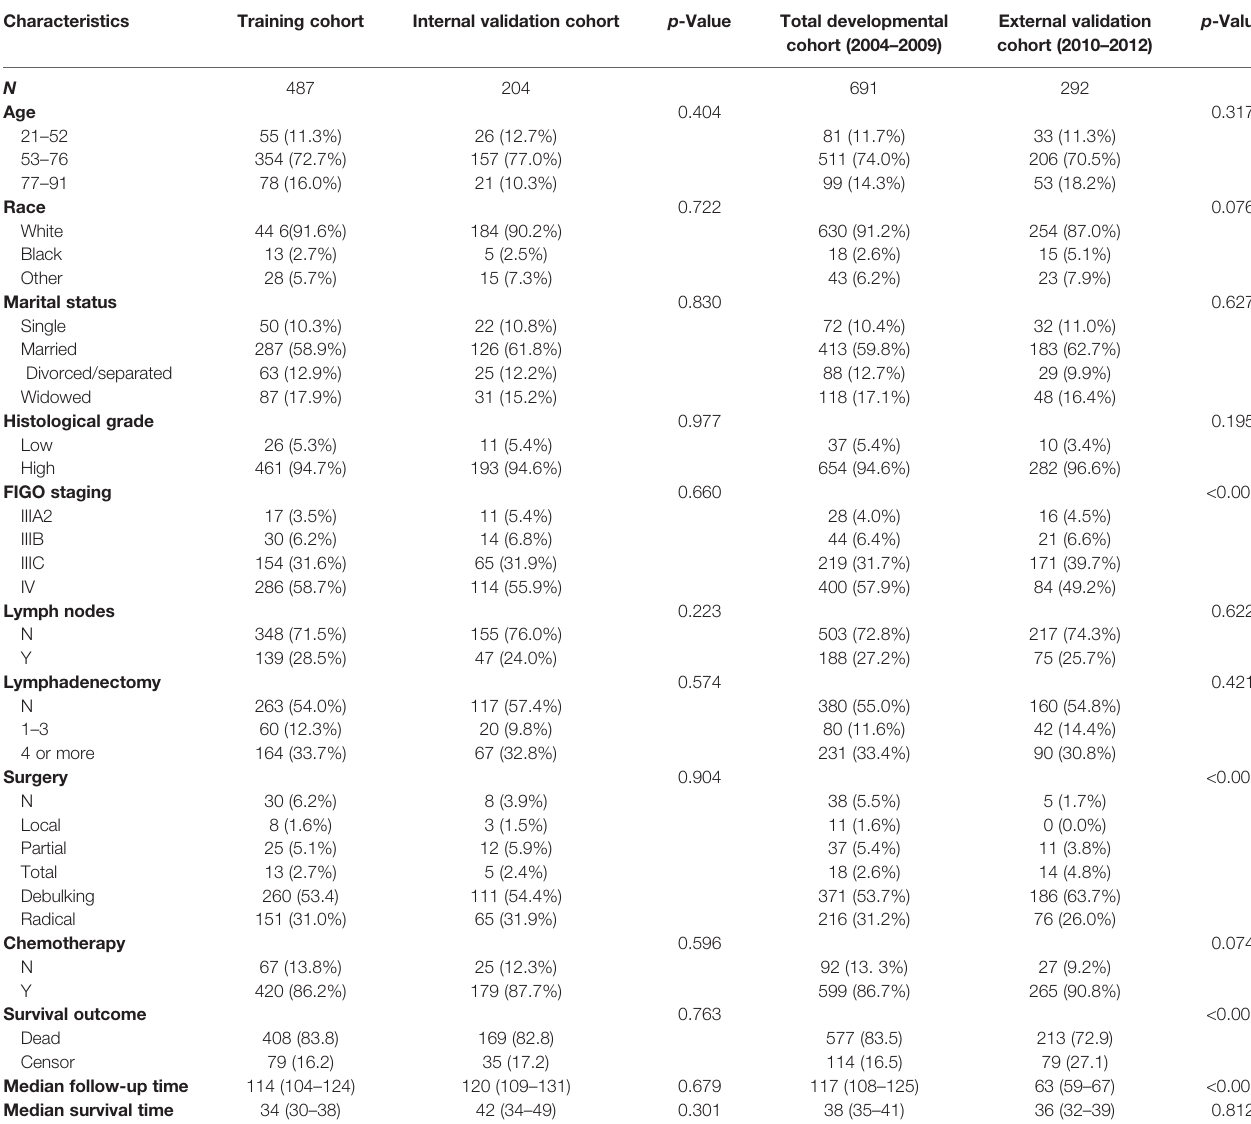
TABLE 1 | Baseline demographic and clinical characteristics of patients with PPSC.